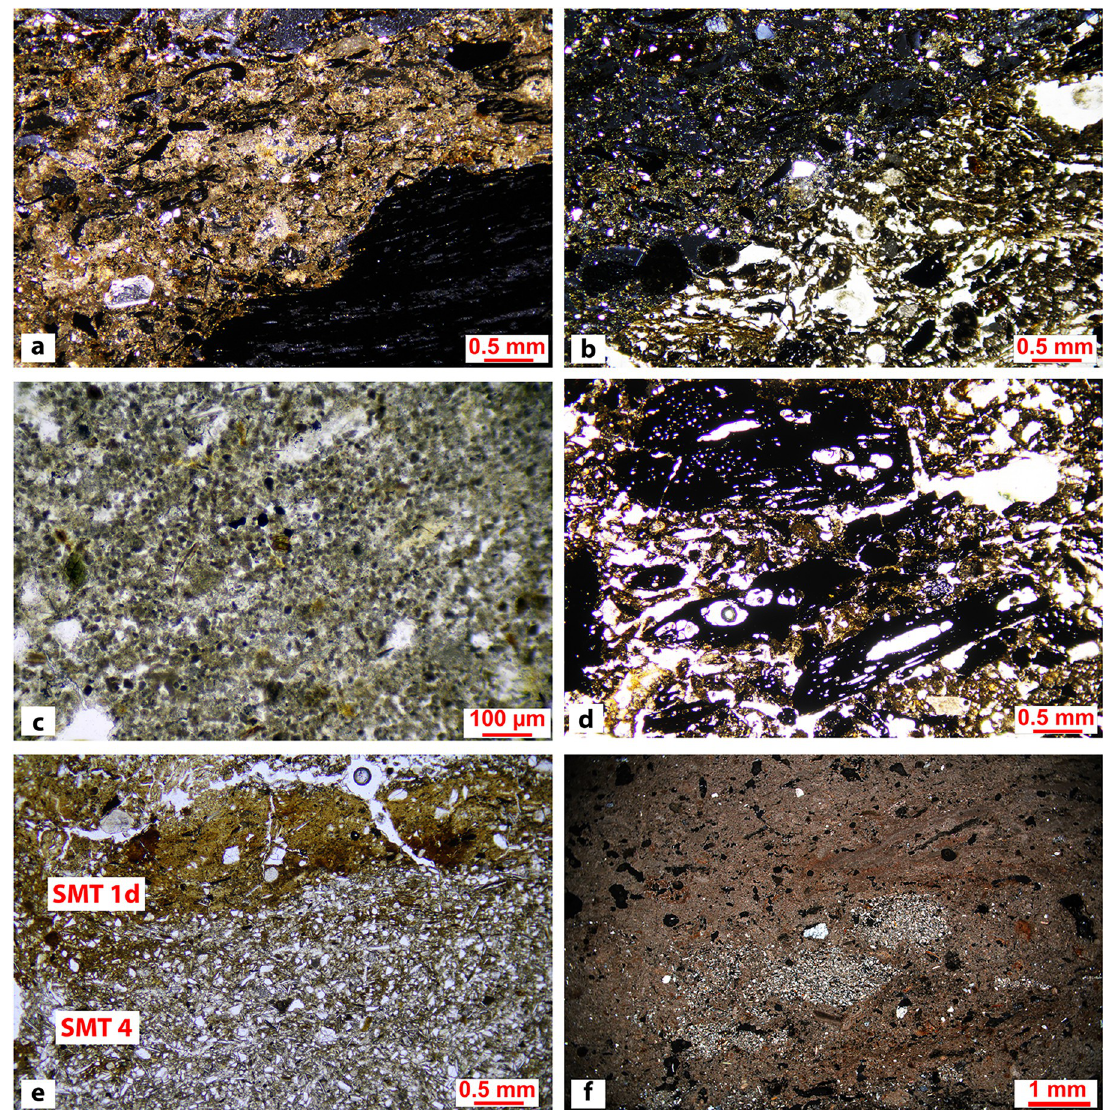
Fig 6. Microphotographs of SMT 1, its sub-types, and SMT 4. (a) SMT 1: ashes mixed with charcoal and charred vegetal matter (XPL). Note the compaction of the material and the alignment of coarser components due to trampling; (b) SMT 1a: compacted ash with charcoal and herbivore dung. The birefringent particles are predominantly ashes, while the optically isotropic fragments are plant material related to herbivore dung (left half: XPL; right half: PPL); (c) SMT 1b: pure wood ash sub-unit (PPL); (d): SMT 1c: coarse charcoal fragments in an ashy matrix. Note the strong alignment of the coarser components due to trampling (PPL); (e): on top, SMT 1d: phosphatic crust, including quartz grains and mica. At the base, SMT 4: hearth preparation, showing a very dense and compact groundmass, composed of sandy silt (mainly quartz grains, mica). Note the abrupt limit between the two sub-units (PPL); (f): SMT 1e: aggregates from dismantled hearth preparations (reworked SMT 4 fragments) included in a pure ash groundmass similar to SMT 1b